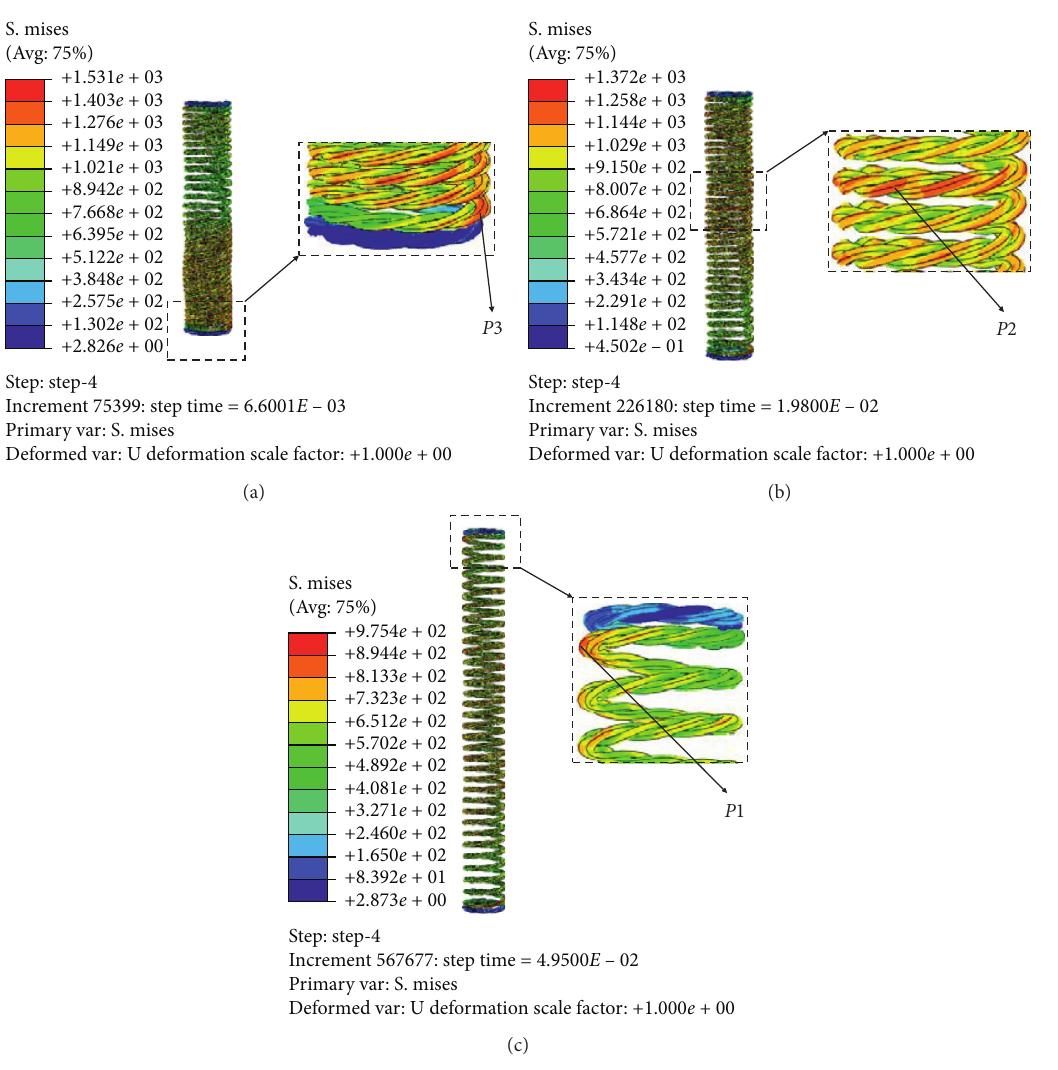
Figure 11: Stress contours of recoil spring at different moments during re-entry. (a) t � 0.006s. (b) t � 0.02s. (c) t �